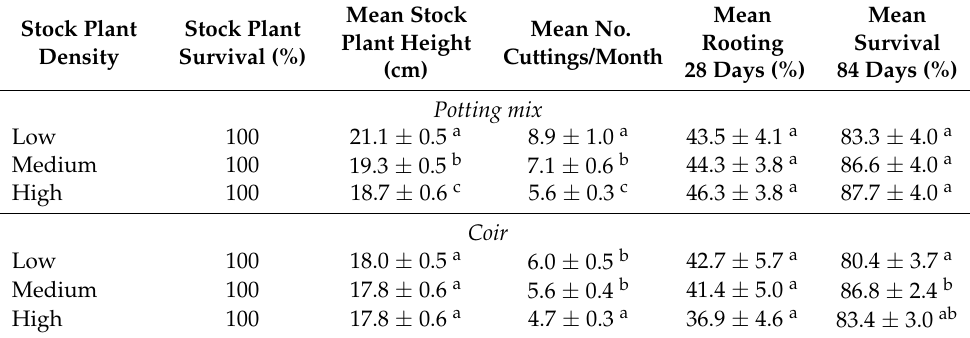
Table 3. Response of stock plant and cutting parameters to media type and planting densities. Means pooled over setting time are shown with SE. Means followed by the same letter are not significantly different at the 95% confidence level.